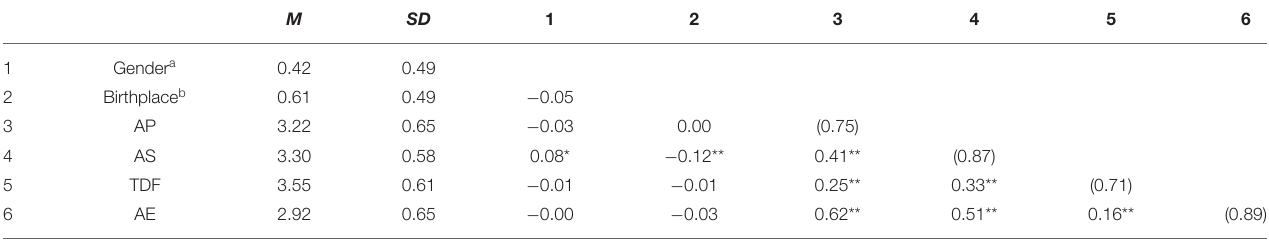
TABLE 1 | Means, standard deviations, correlations, and reliabilities (in brackets).